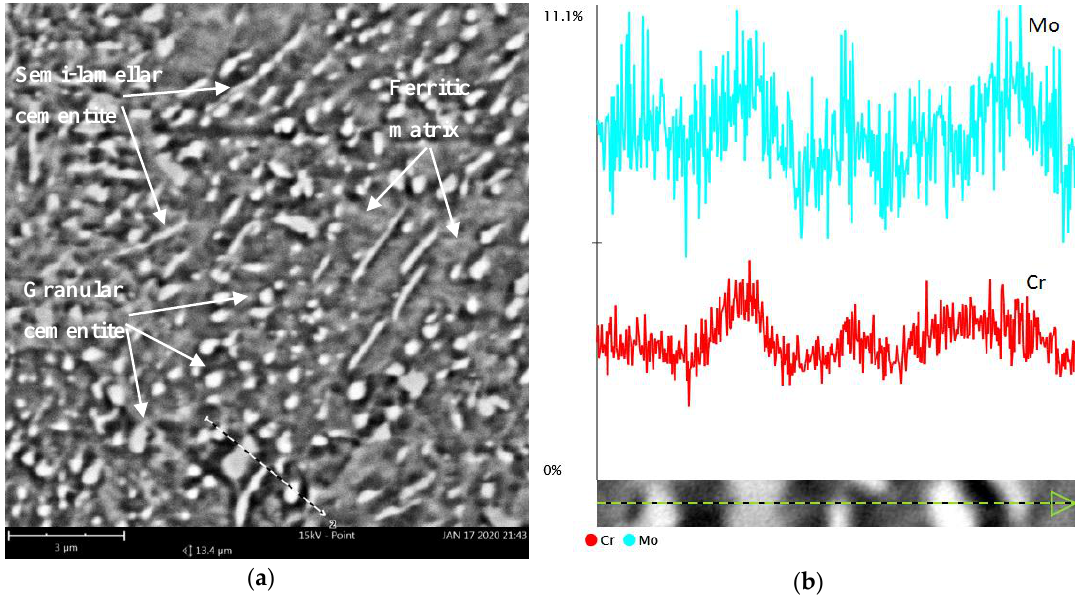
Figure 4. Microstructure of 42CrMo4 steel annealed according to scheme no. 4 ( a ), ( b ) molybdenum and chromium content in the line-scanned area from ( a ), scanning electron microscopy-energy dispersive spectrometer (SEM-EDS).